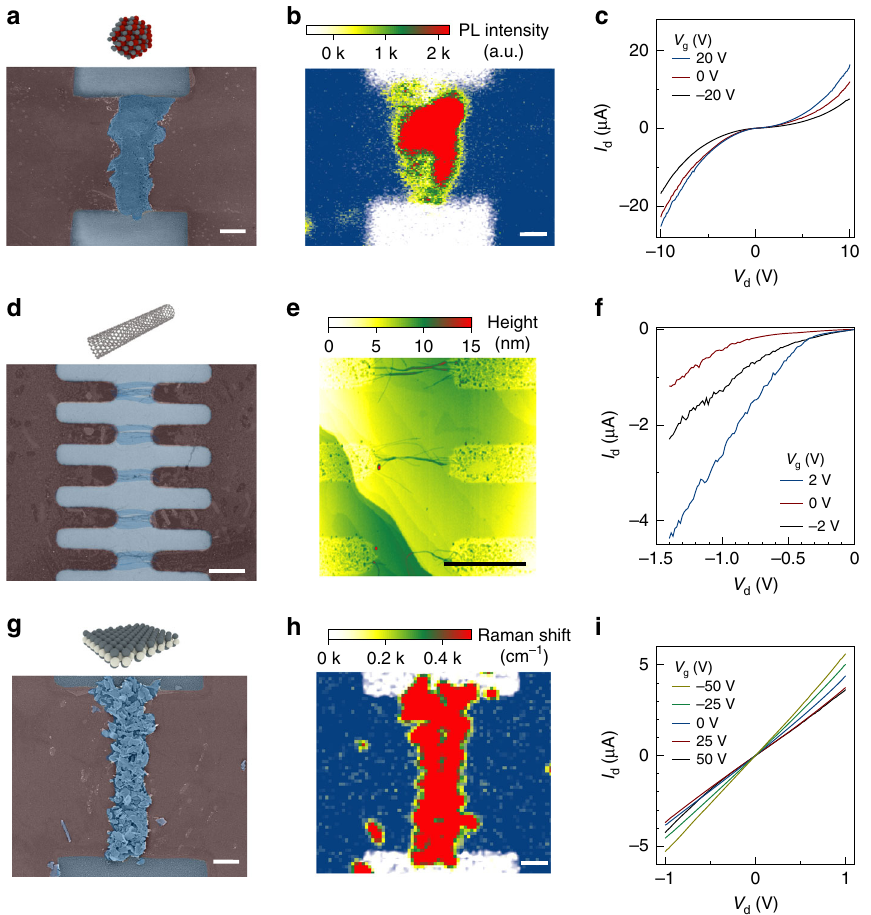
Fig. 4 Spatially resolved deposition, characterization and device integration of 0D, 1D, and 2D semiconductors. a Scanning electron microscope (SEM) false color image of a CdSeS/ZnS quantum dot assembly. Deposition conditions are V DEP = 10 V, f = 1 MHz, t = 10 min. Scale bar: 1 µ m. b Raman 2D intensity false color image (white: 20 arb. units, blue: 100 arb. units) indicating the graphene areas, overlaid by a photoluminescence intensity false color image spectrally integrated at (580 ± 10) nm indicating the position of quantum dots. The images are taken at the same area as in a . c Electrical transport characteristic of a quantum dot thin fi lm device. Scale bar: 1 µ m. d SEM false color image of carbon nanotube assembly. Deposition conditions are V DEP =